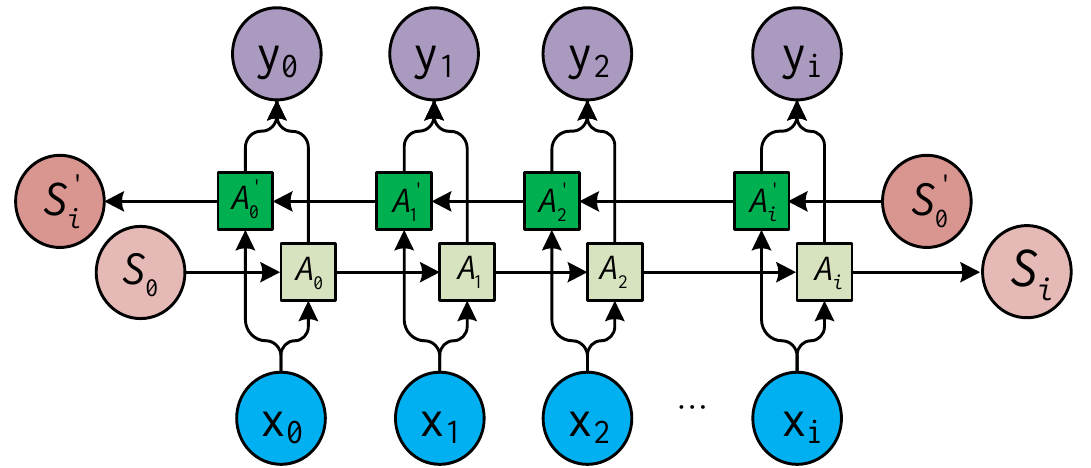
Figure 5. Bidirectional recurrent neural network (BI-RNN) structure diagram.